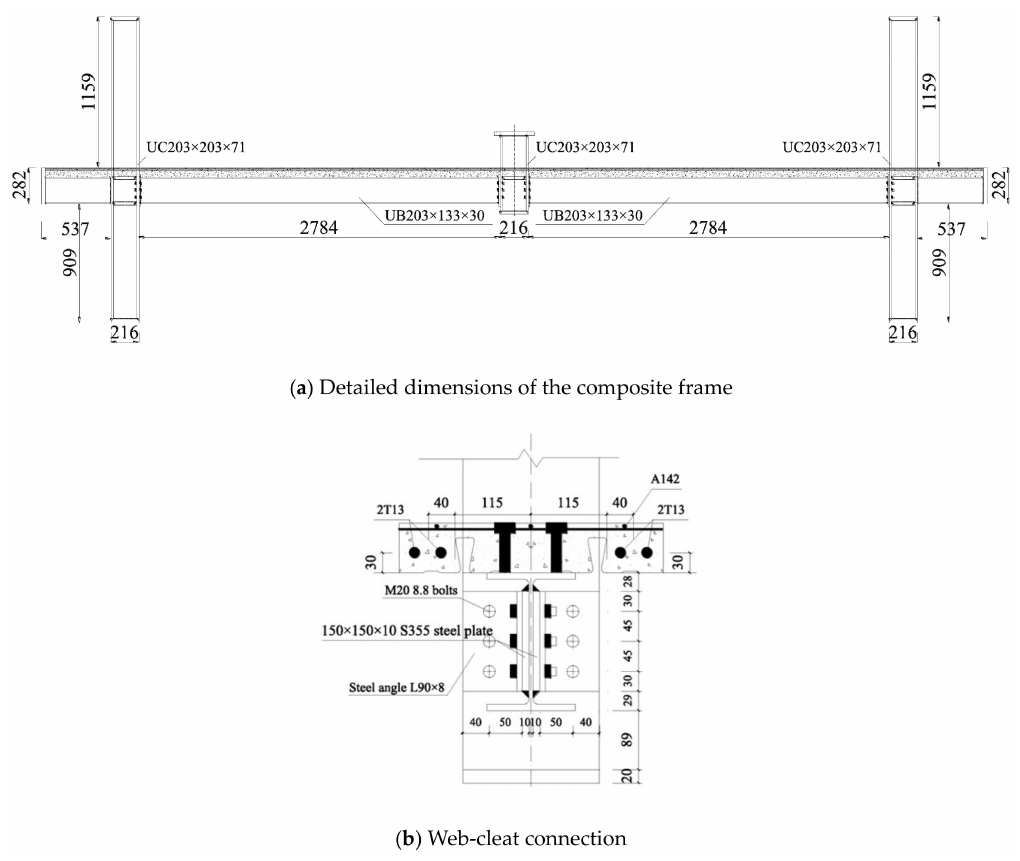
Figure 1. Test specimen in Yang et al. [10] (unit: